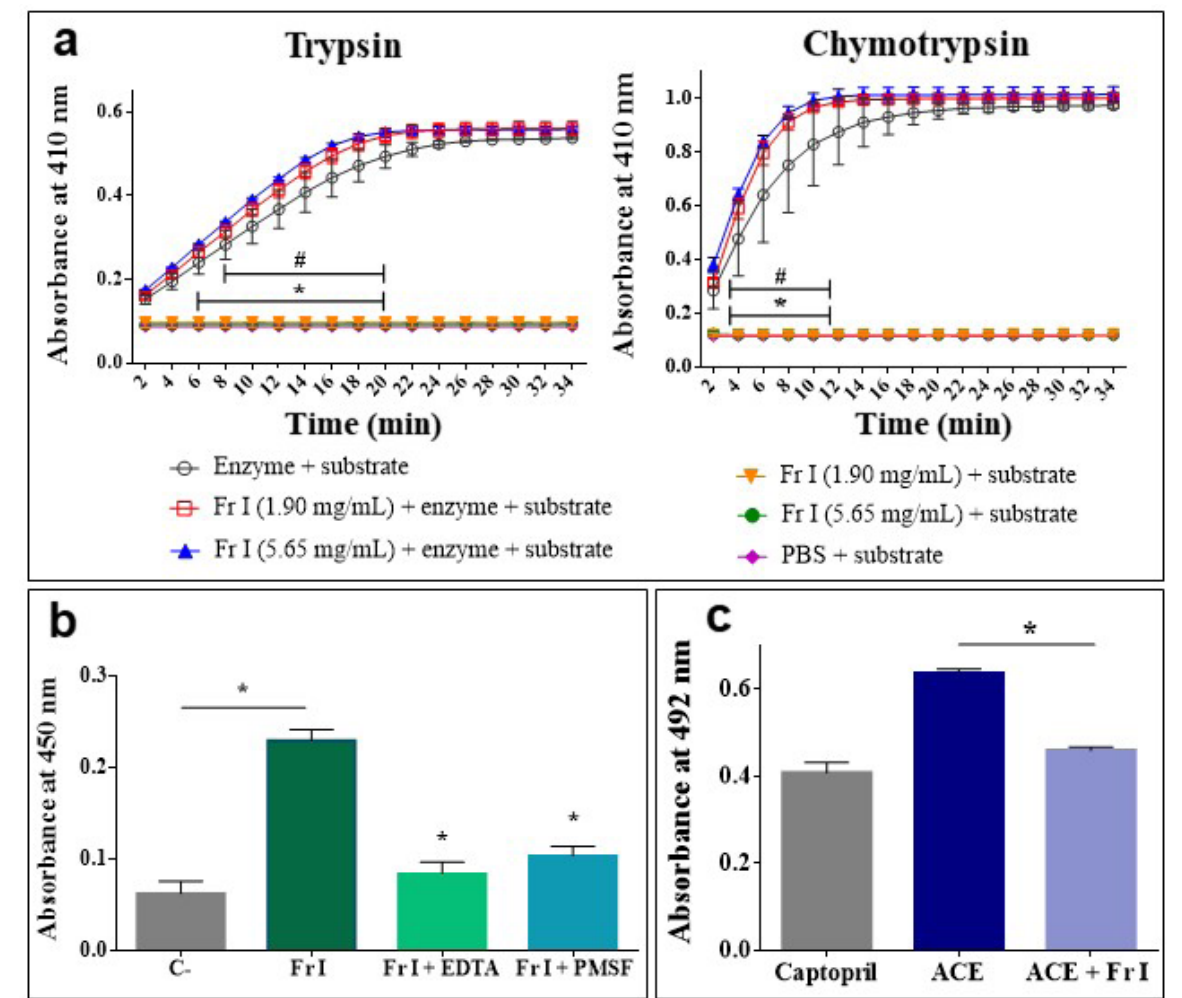
Figure 2. A: Trypsin and chymotrypsin activity assay in the presence of fraction I in two concentrations (1.90 mg/mL and 5.65 mg/mL). The absorbance was determined at 410 nm. *p<0.05 Fr I (5.65 mg/mL) + Trypsin + substrate vs Trypsin + substrate; #p<0.05 Fr I (1.90 mg/mL) + Trypsin + substrate vs Trypsin + substrate. B: Proteolytic activity of Fraction I (10 μL, 47 μg/μL) over azocasein in the absence and presence of inhibitors of metalloprotease (EDTA) and serine protease (PMSF). The absorbance was determined at 450 nm. *p<0.05 Fr I + EDTA and Fr I + PMSF vs Fr I . C: Inhibition assay of ACE activity by Fraction I (48.4 mg/mL). Reactions were read at 492 nm. *p<0.05 ACE + Fr I vs ACE. C-: negative control; Fr: Fraction I. Values are expressed as mean ± SD.